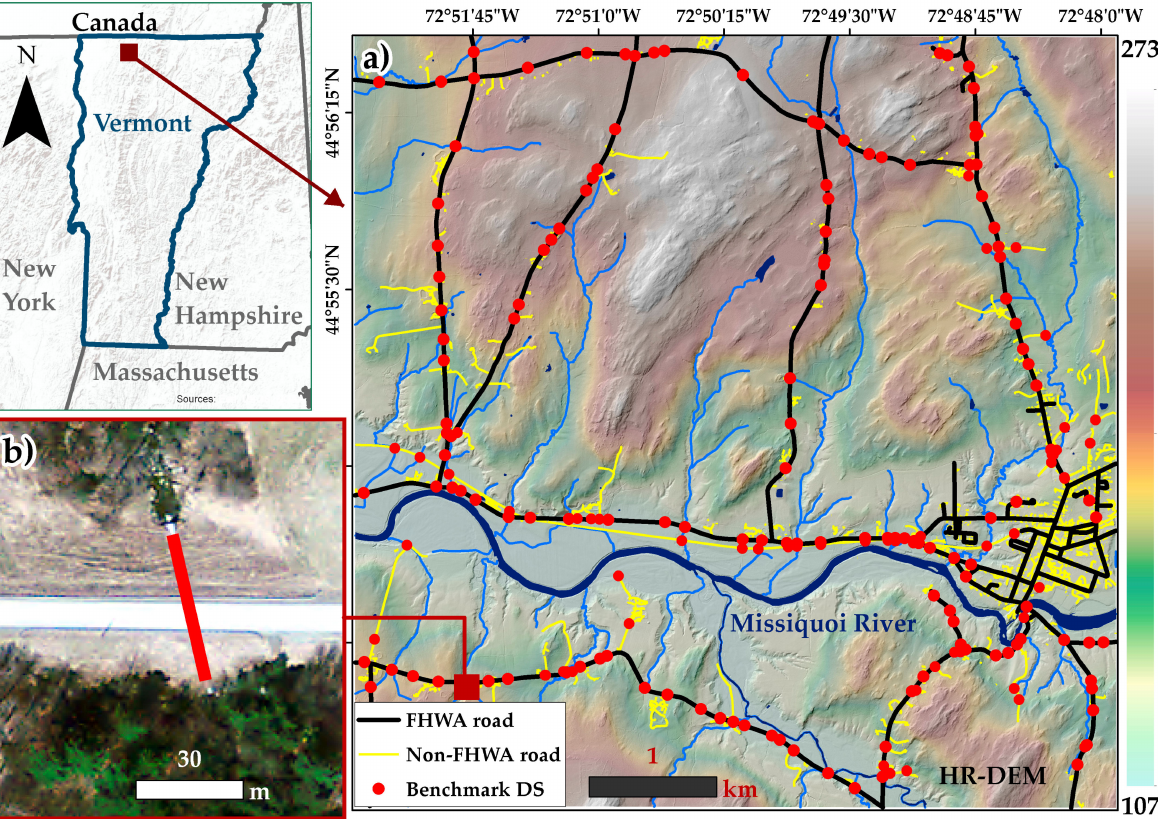
Figure 2. The focus study area in northern Vermont, USA. ( a ) High-resolution digital elevation model (HR-DEM) obtained from airborne laser scanning (ALS) data, road centerlines of the federal highway authorities (FHWA) (black lines), and non-FHWA roads (yellow lines). The red dots indicate the benchmark drainage structure (DS) dataset with DS locations and orientations as shown in ( b ), an inset map of a